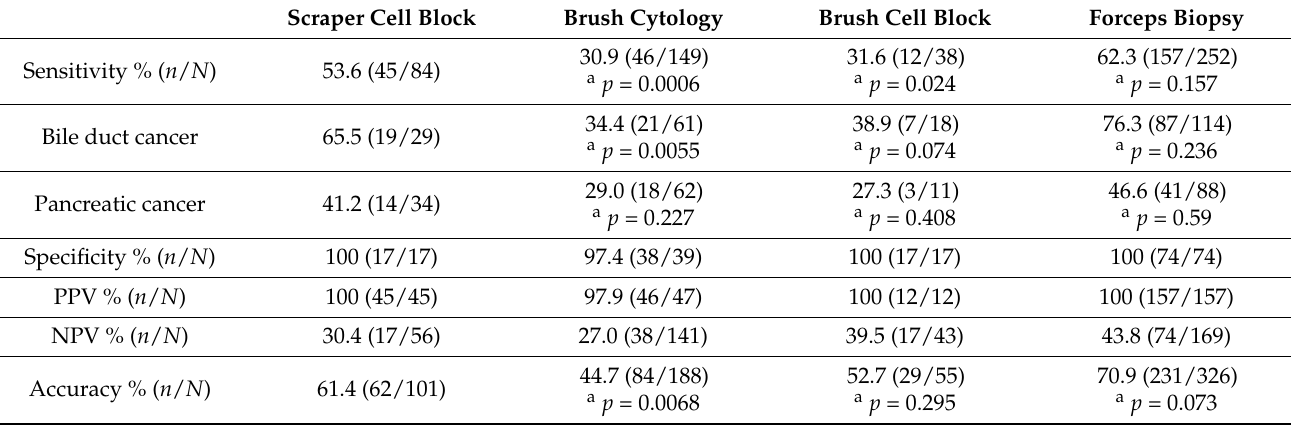
Table 2. Diagnostic yield of each sampling